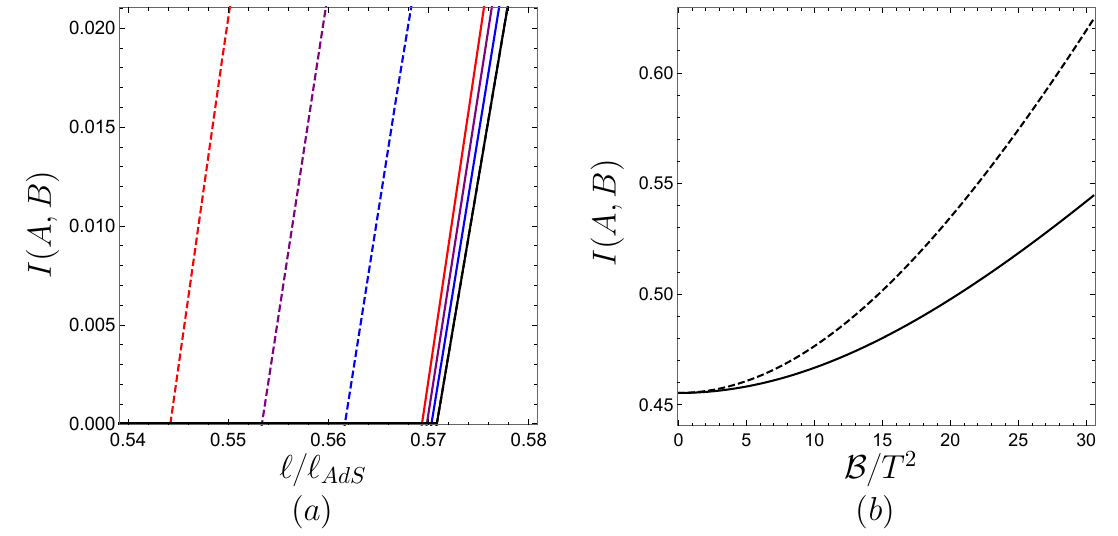
Figure 5 . (a) Mutual Information (in units of V 2 =G ) as a function of the strip’s width ‘ for N several values of =T 2 . The curves correspond to =T 2 = 0 (black curve), B B curves), =T 2 = 21 : 2 (purple curves), =T 2 = 27 : 5 (red curves). (b) Mutual information (in units B B of V 2 =G ) versus =T 2 for strips of (cid:12)xed width ‘=‘ AdS = 0 : 75. The continuous (dashed) curves N B correspond to the results for orthogonal (parallel) strips.